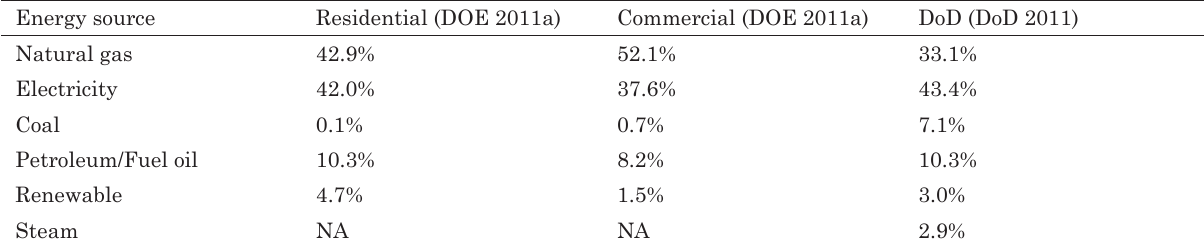
Table 1. United States and DoD energy consumption by